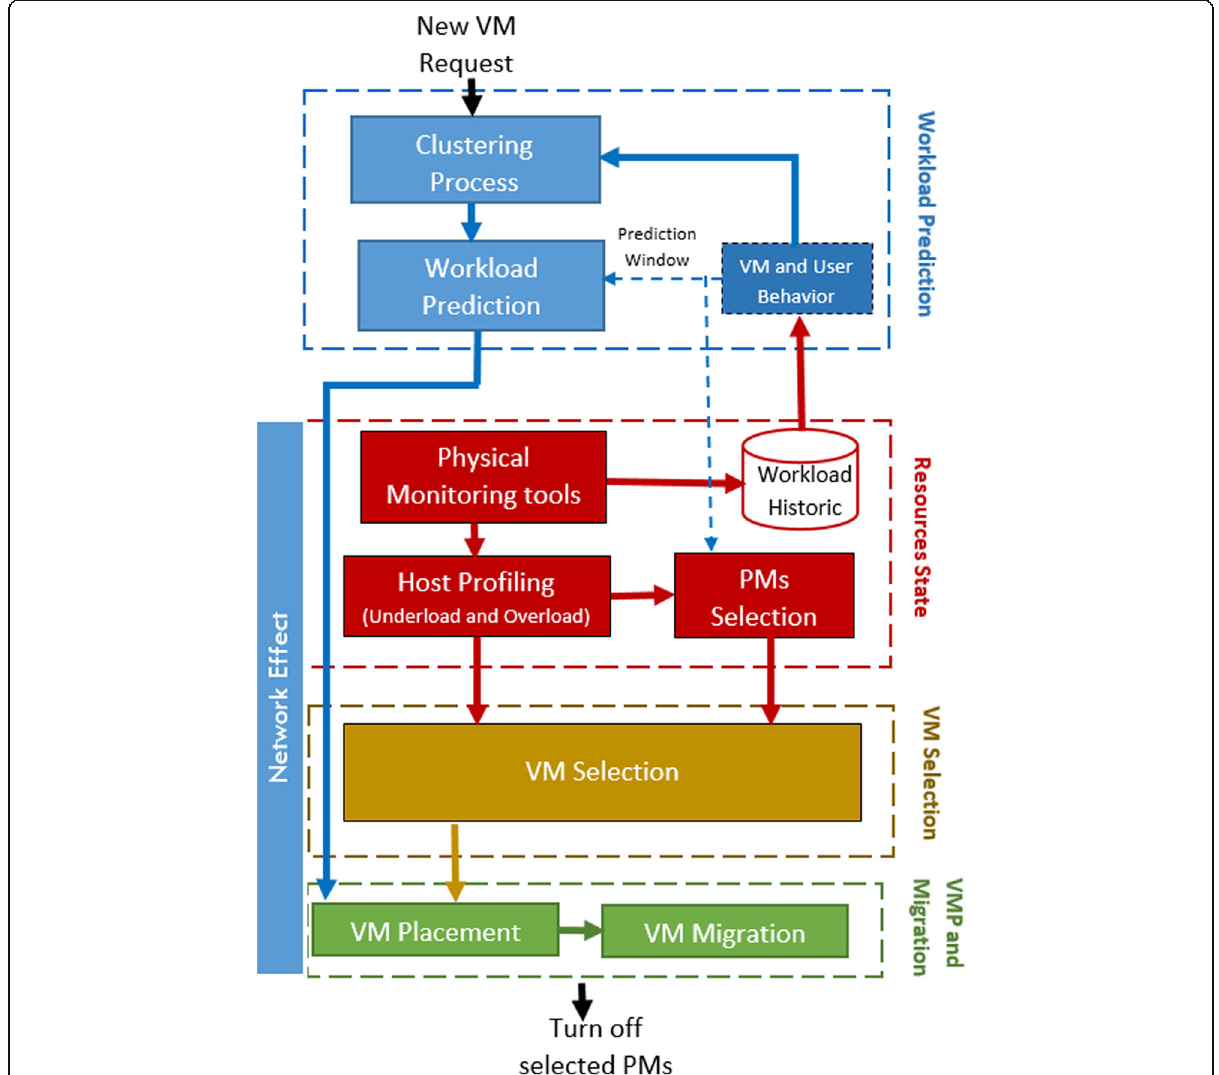
Fig. 2 Proactive dynamic VM consolidation literature review